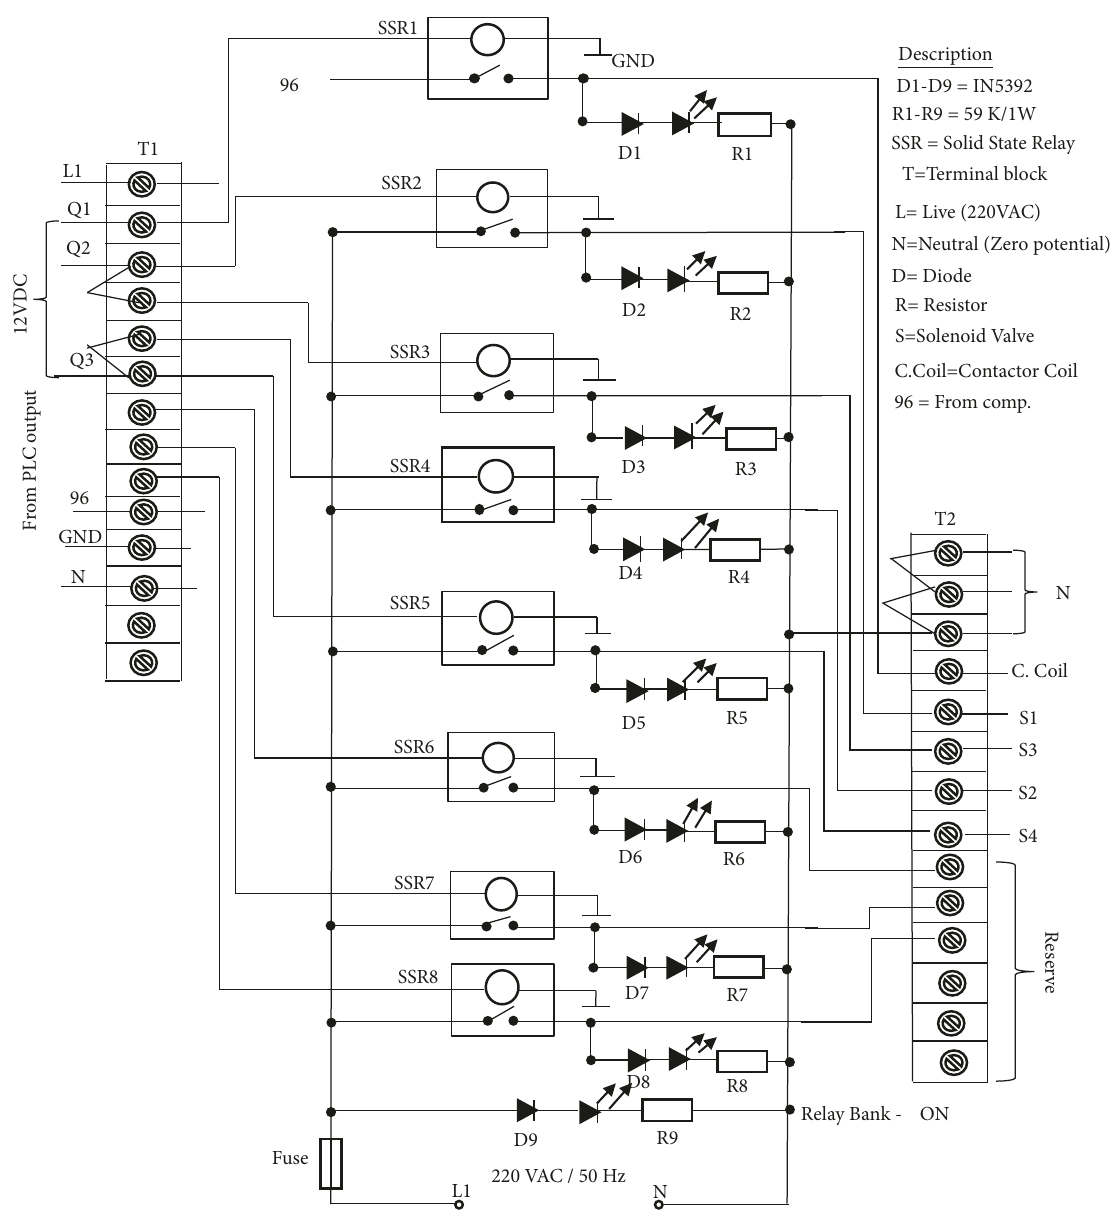
Figure 11: Designed eight (8)-way relay bank to operate the solenoid